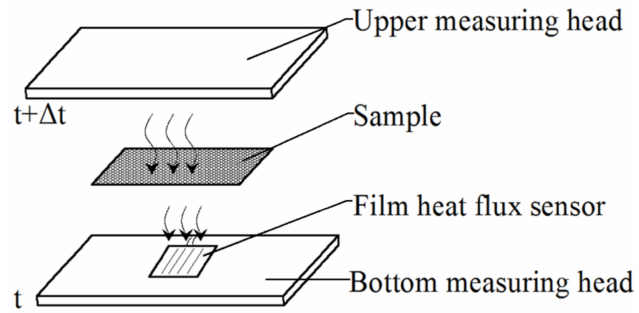
Figure 4. Schematic diagram of thermal